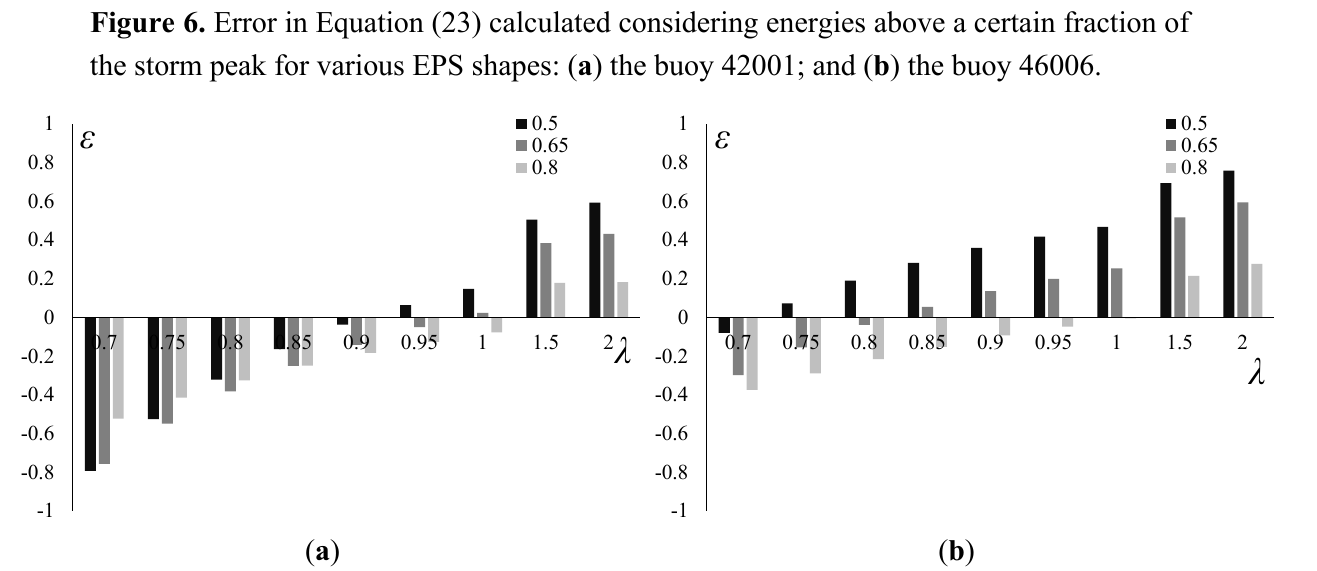
Figure 7. Error in Equation (23) associated with the downtime pertaining to three fractions of the storm peak for various EPS shapes: ( a ) the buoy 42001; and ( b ) the buoy